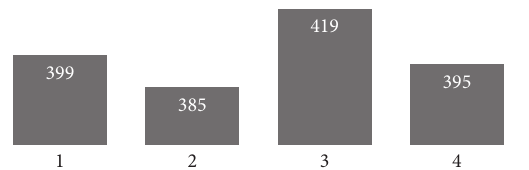
Figure 6: Category III: use of the platform, search for information, use of resources, and language proficiency.